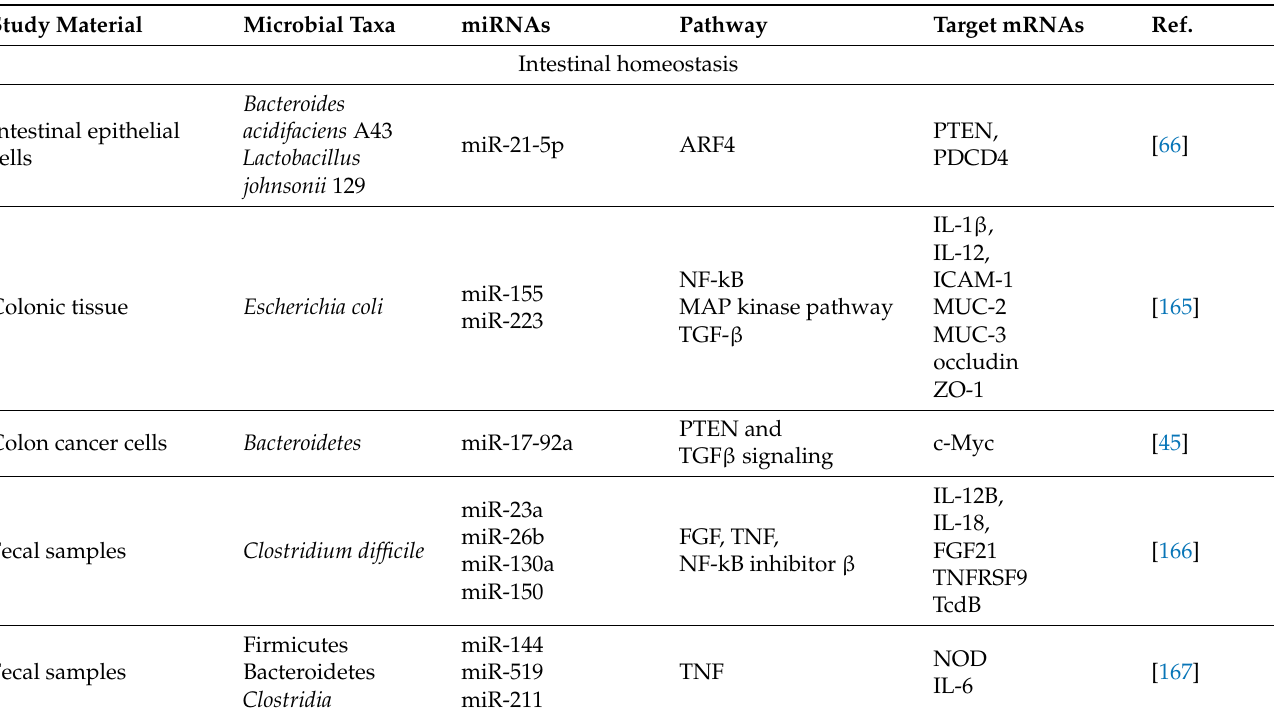
Table 2. The role of gut microbiota–miRNA interactions. The table summarizes the studies con- cerning the role of microbiota–miRNA interactions in intestinal homeostasis, immunology, cancer development, and